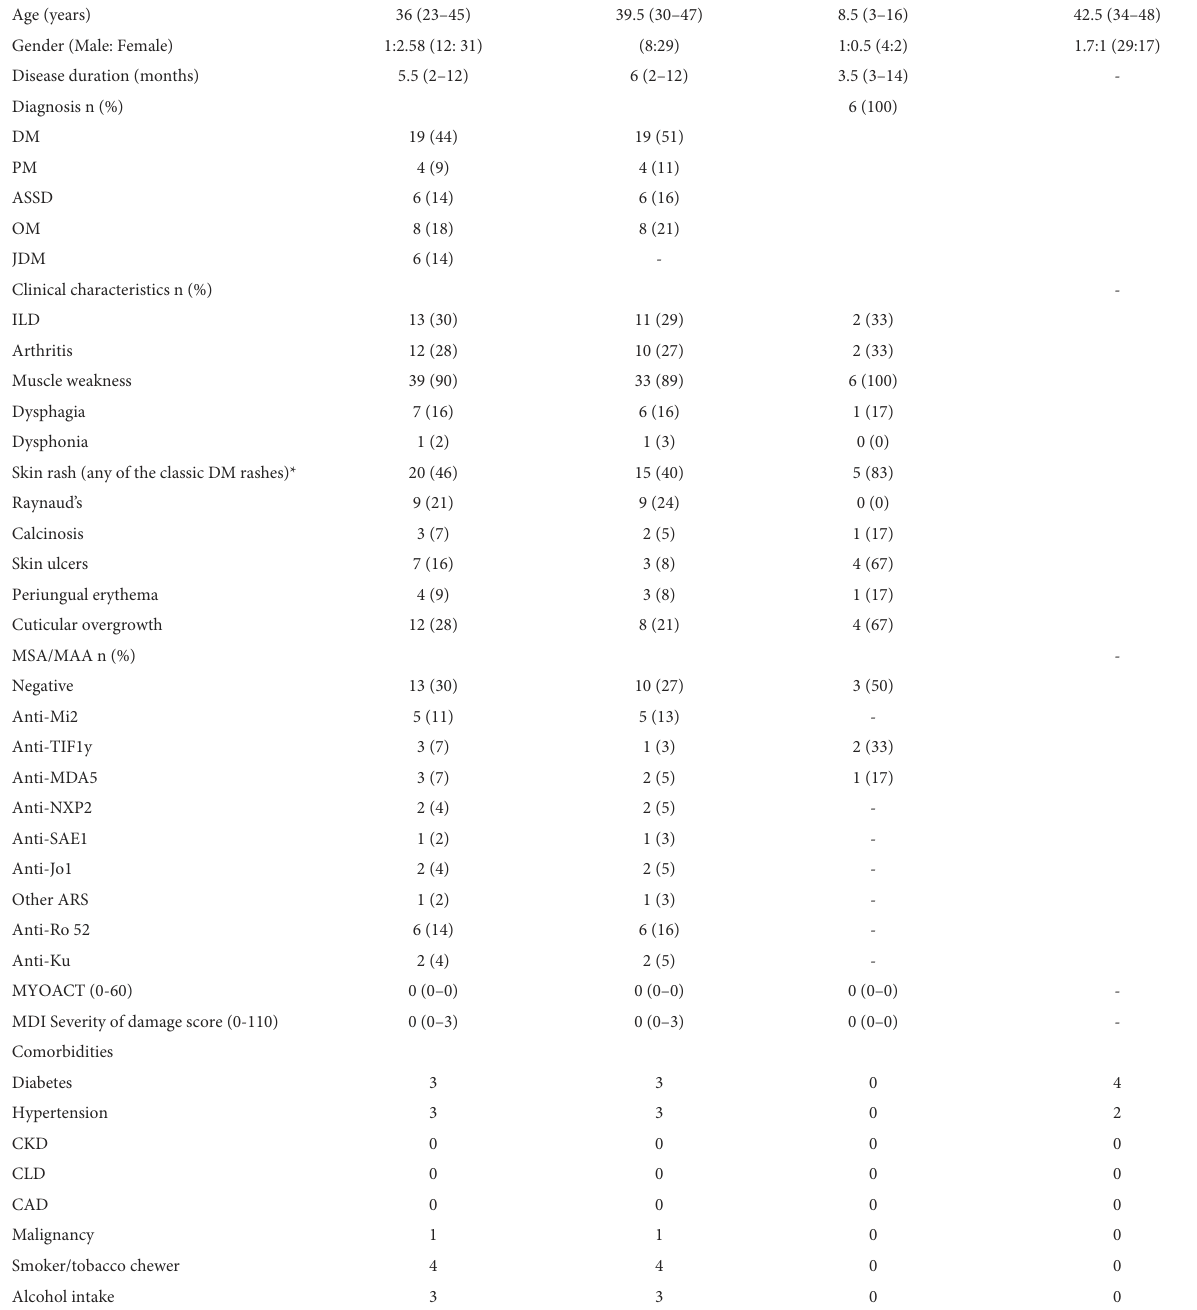
ASSD, Anti-synthetase syndrome; ARS, Aminoacyl tRNA synthetase antibody; DM, Dermatomyositis; PM, Polymyositis; JDM, Juvenile dermatomyositis; OM, Overlap myositis; ILD, Interstitiallungdisease;MYOACT,MyositisDiseaseActivityAssessmentVisualAnalogScale;MDI,severityofdamagescoreissumof11VASscorestoassessdamage.